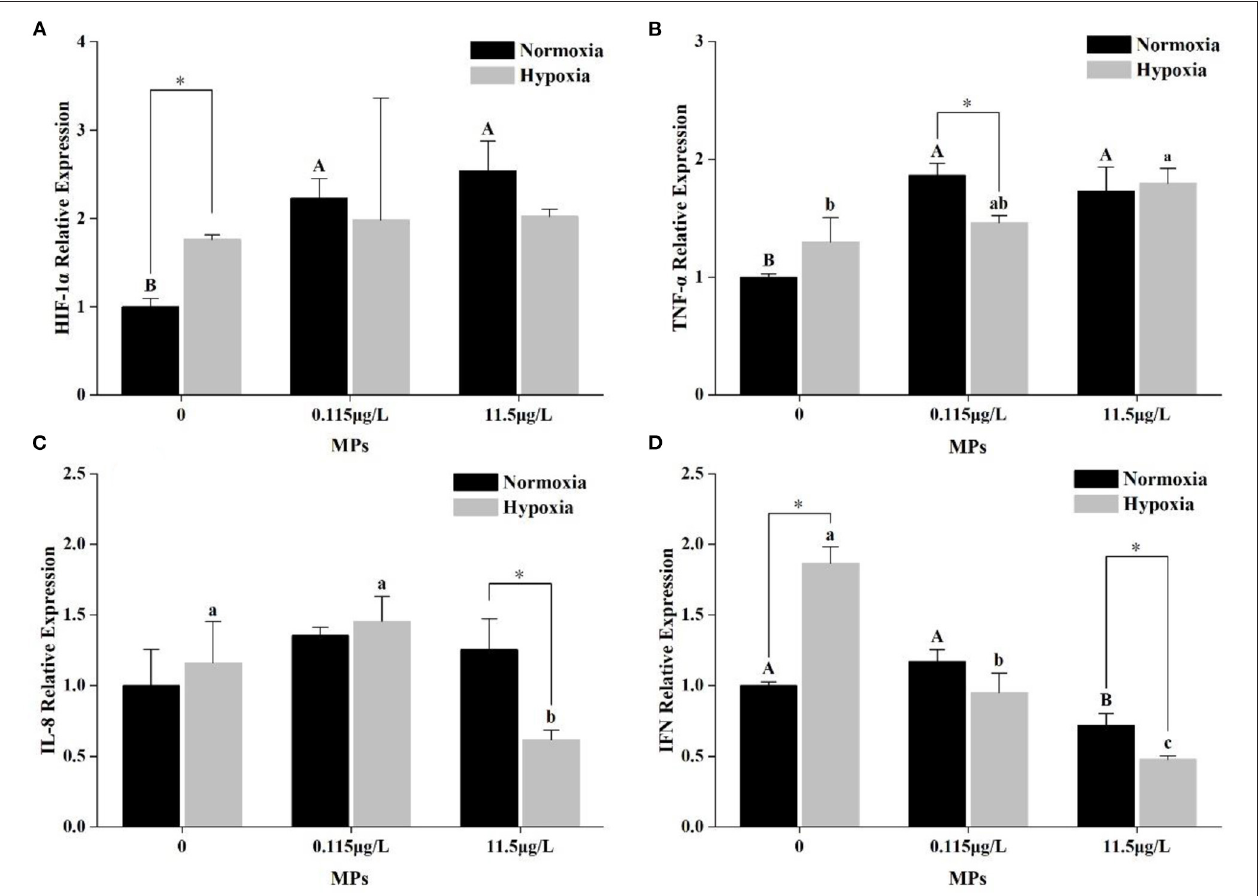
FIGURE 4 | Relative expression of HIF-1 α (A) , TNF (B) , IL-8 (C) , and IFN (D) under different treatments (normoxia + 0 MPs, normoxia + 0.115 µ g/L MPs, normoxia + 11.5 µ g/L MPs, hypoxia + 0 MPs, hypoxia + 0.115 µ g/L MPs, and hypoxia + 11.5 µ g/L MPs) of P. fulvidraco . Different capital letters and different lowercase letters indicate significant differences among MP concentrations in normoxia and hypoxia ( P < 0.05). “*” represents the significant difference between normoxia and